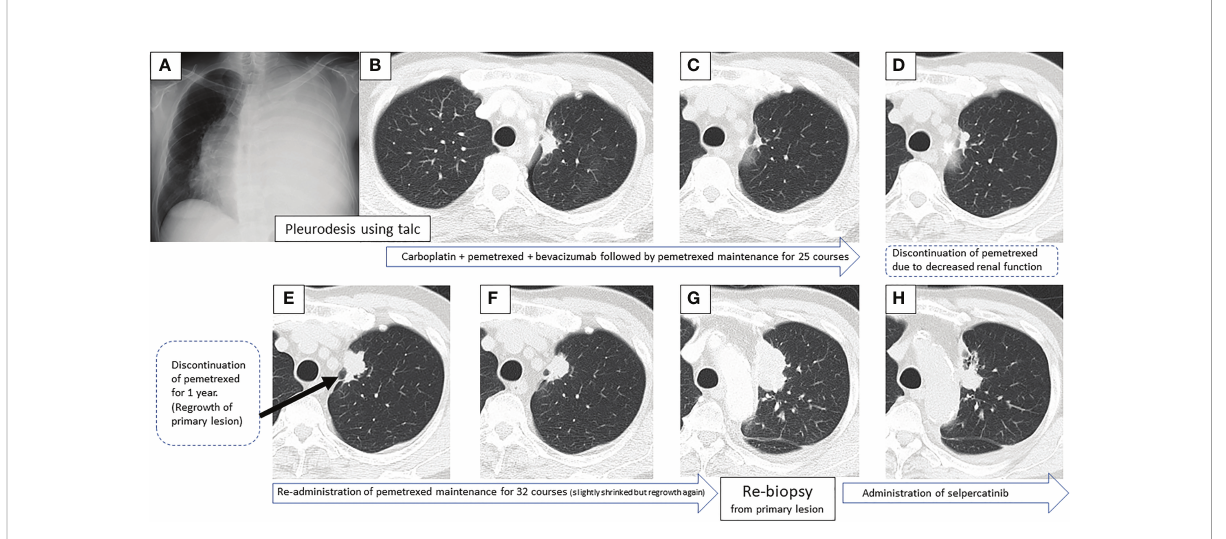
FIGURE 1 Sequential images of the primary lesion over 7 years, from the time of the fi rst visit to the introduction of the second